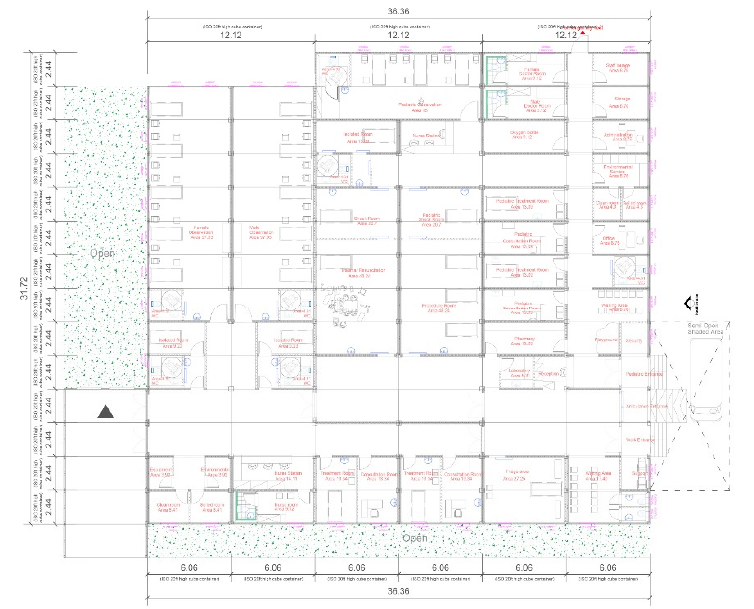
Figure A1. Site plan of the relocatable hospital in Mosul city, Case study.